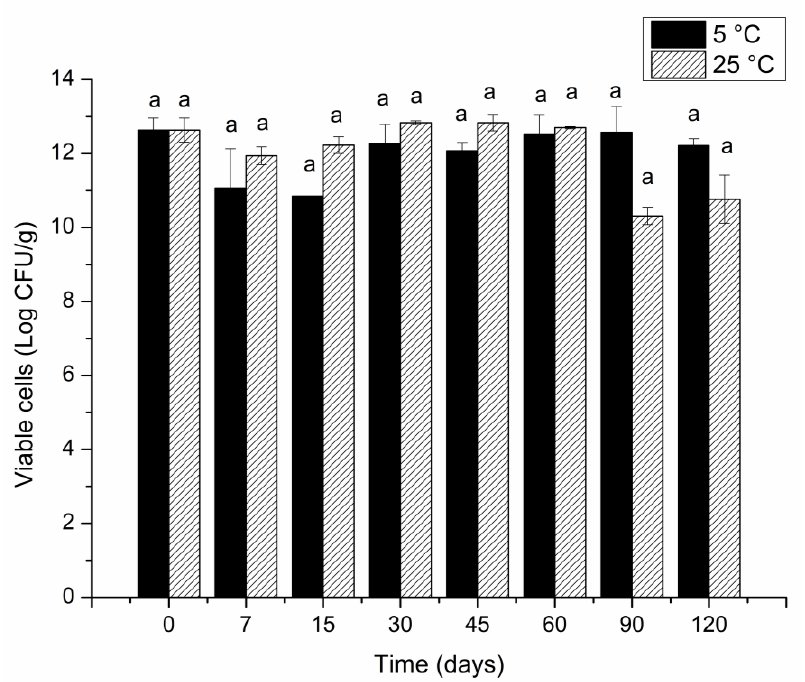
Figure 4. Viability of microparticles containing L. acidophilus in porcine gelatin by O/W emulsification (LAEG) during 120 days of storage at 25 °C and 5 °C. a Equal letters in the same temperature storage indicate no statistically significant difference ( p > 0.05) at different times.